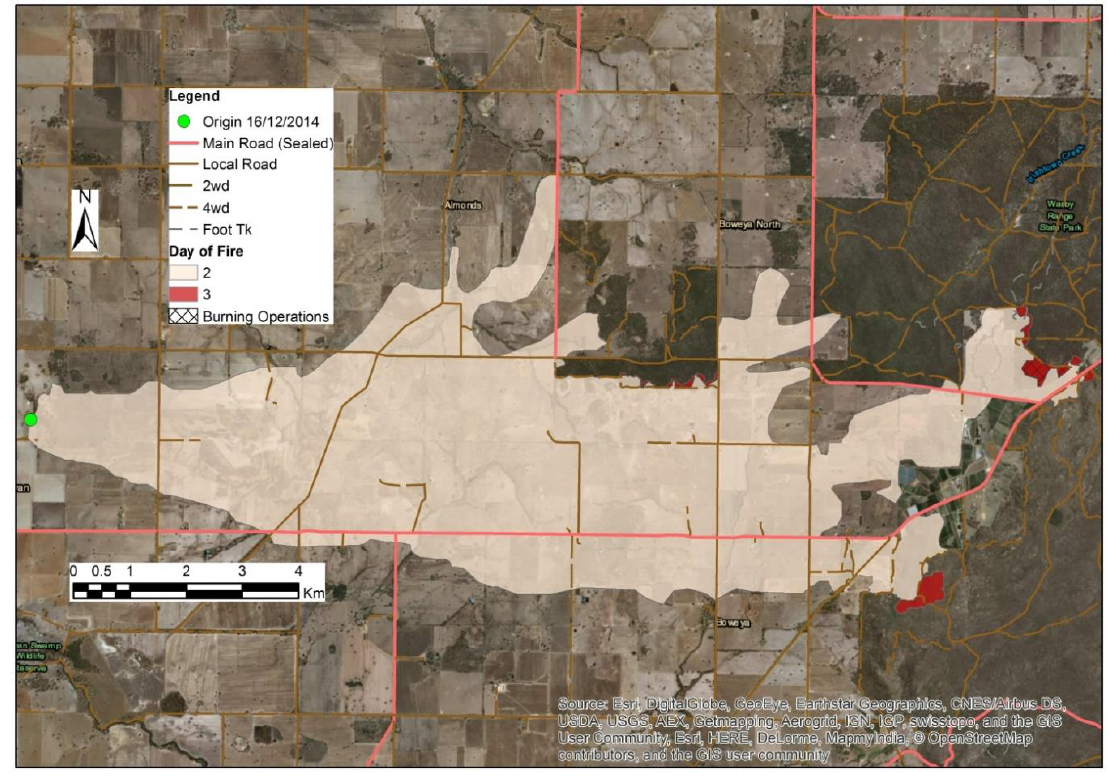
Figure A7. Lake Rowan fire progression map.